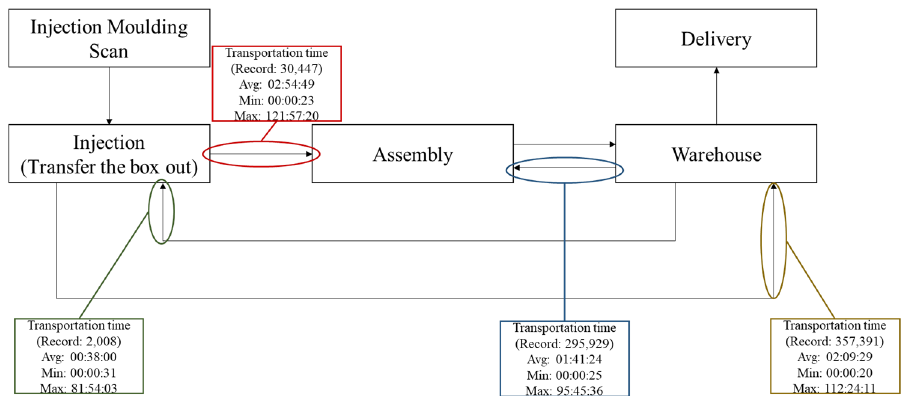
Figure 10. Transportation time for each in-house transit process before removing outliers.